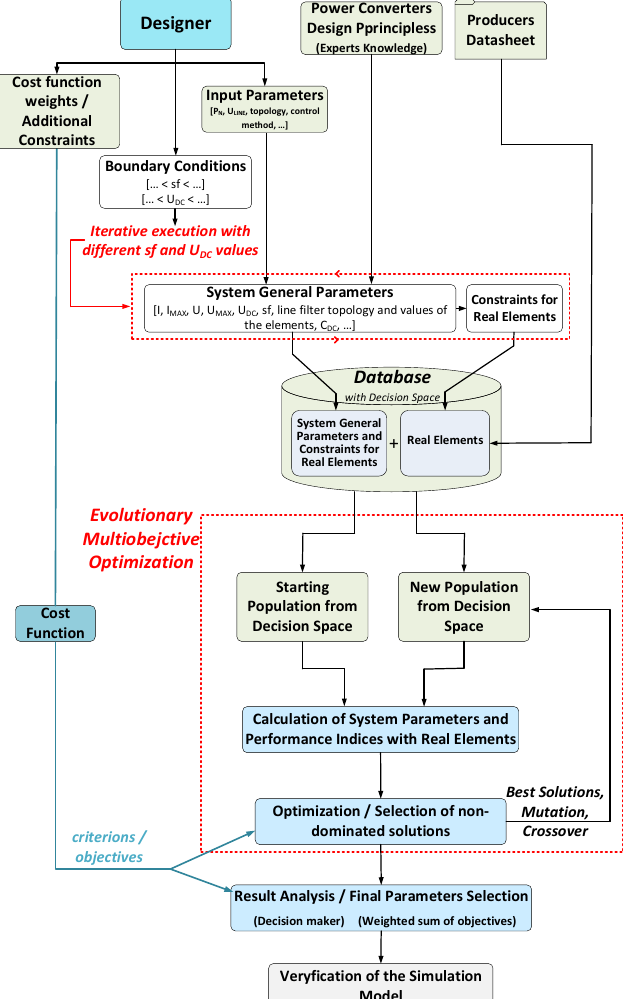
Fig. 8. Proposed Multi-Objective Optimization (MOO) procedure for Grid Connected Converter